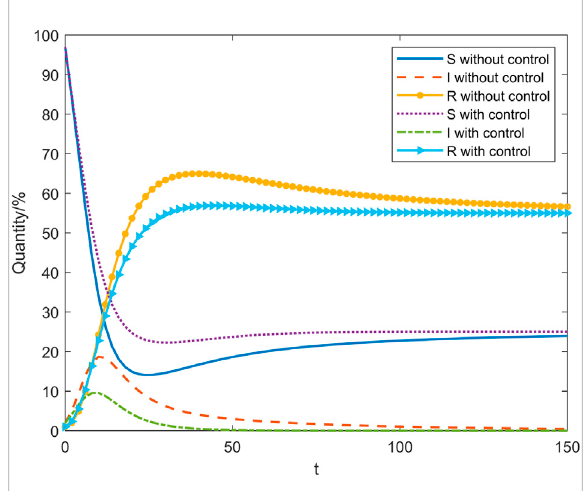
FIGURE 10 Comparison of the changes in the number of nodes without control and subject to the control of an uninformed person.